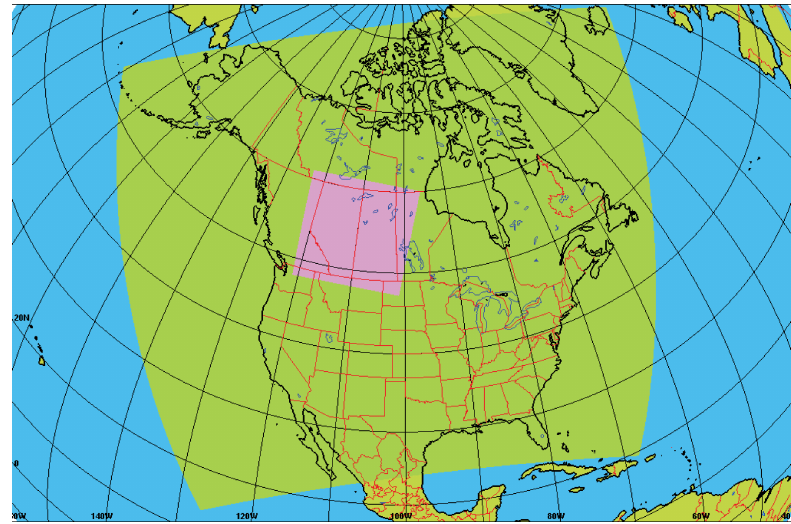
Figure 2. Map of 10km resolution continental piloting model domain (green) and 2.5km resolution nested model domain (purple).